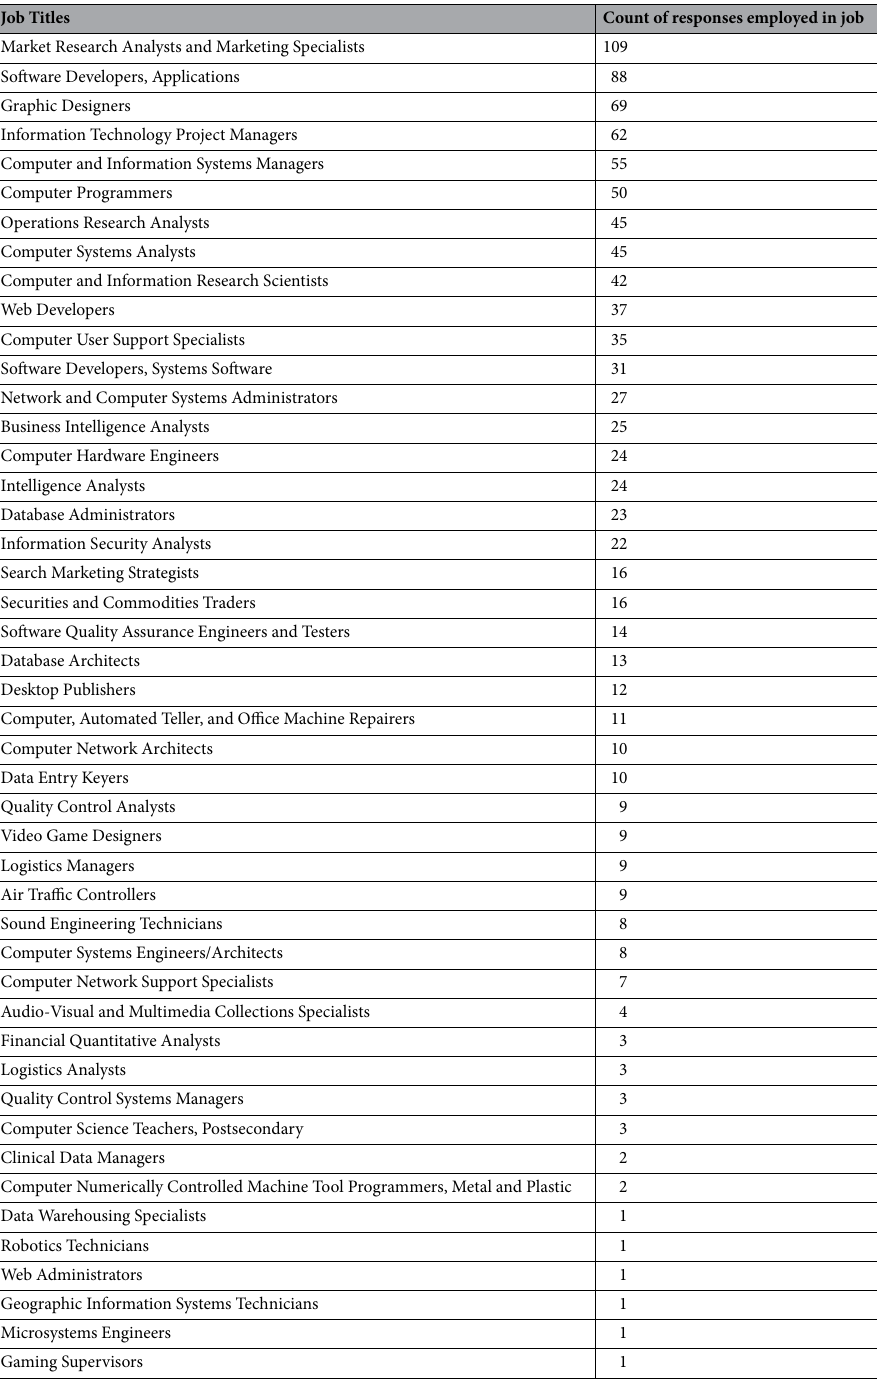
Table 2. Job titles characterized as CS and counts of responses in random